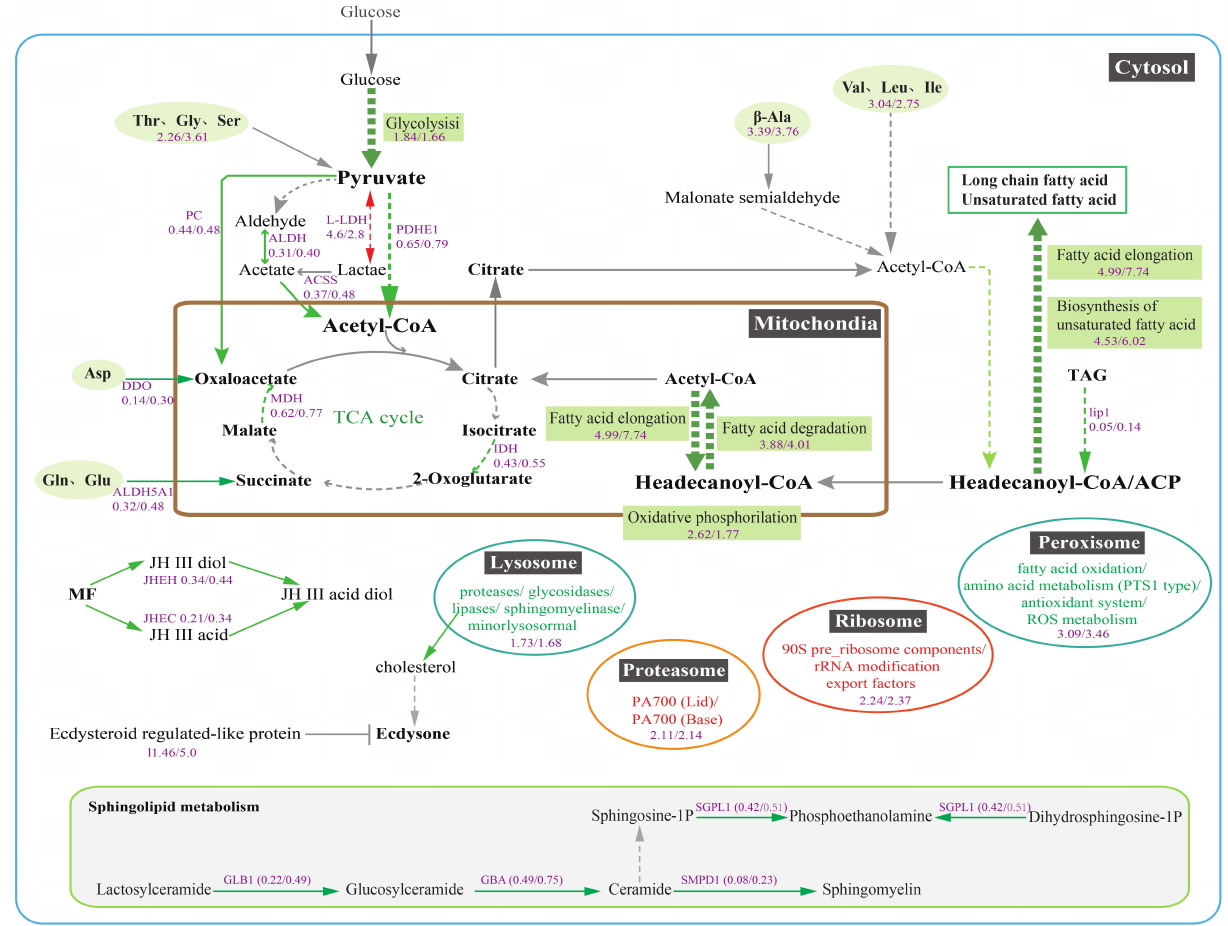
Figure 8. Overview of the main regulatory pathways in the EHP-infected hepatopancreas. The green color indicates pathways, and the arrows represent down-regulated metabolic processing and reaction steps. The red-colored arrow represents up-regulated reaction steps and orange colored indicates up-regulated processing or proteins. The purple color indicates the participant enzymes or the fold enrichment value of metabolic pathways, and the value in front of the diagonal represents the ratio of H vs. C, while the value behind the diagonal represents the ratio of L vs.